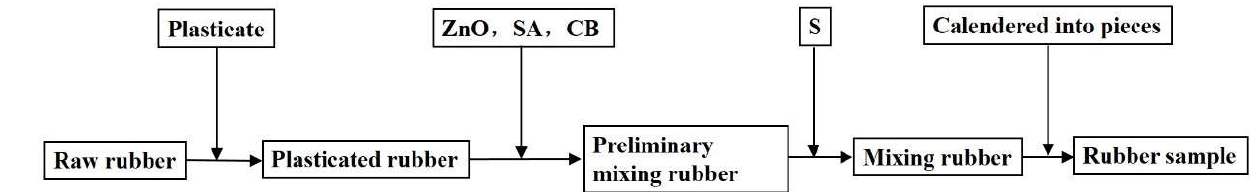
Figure 3. The process flow diagram of the open mixing technology.